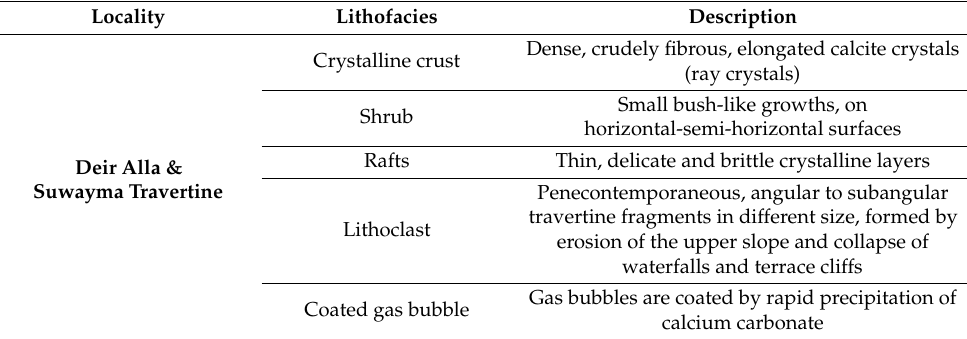
Table 1. Summary of travertine and tufa lithofacies in the studied travertine